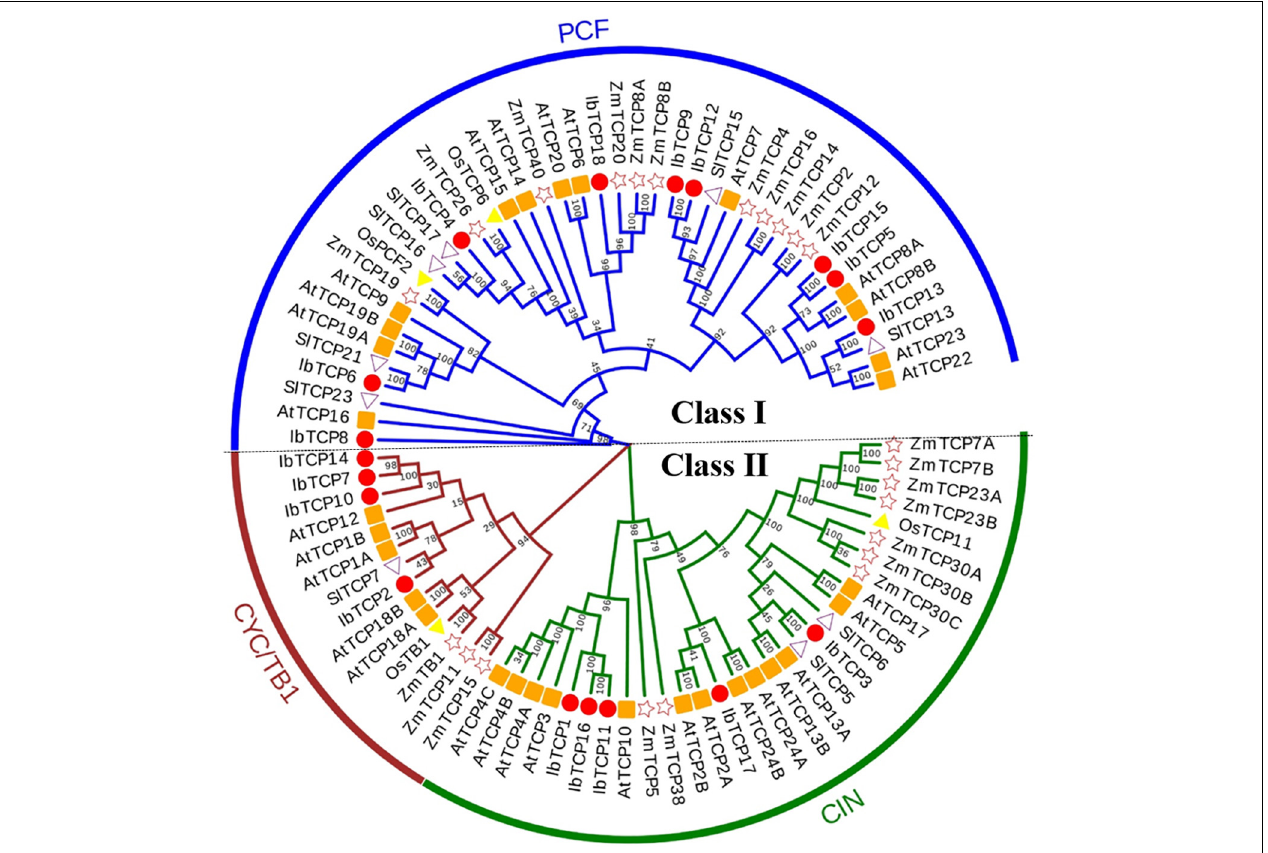
FIGURE 2 | Phylogenetic analysis of TCP TFs from I. batata (IbTCP), Arabidopsis (AtTCP), rice (OsTCP), maize (ZmTCP), and S. lycopersicum (SlTCP). The phylogenetic tree was constructed from 88 full-length protein sequences from I. batata (18), Arabidopsis (31), rice (7), maize (23), and S. lycopersicum (9) using the neighbor-joining method in MEGA 6.0 with 1000 bootstrap